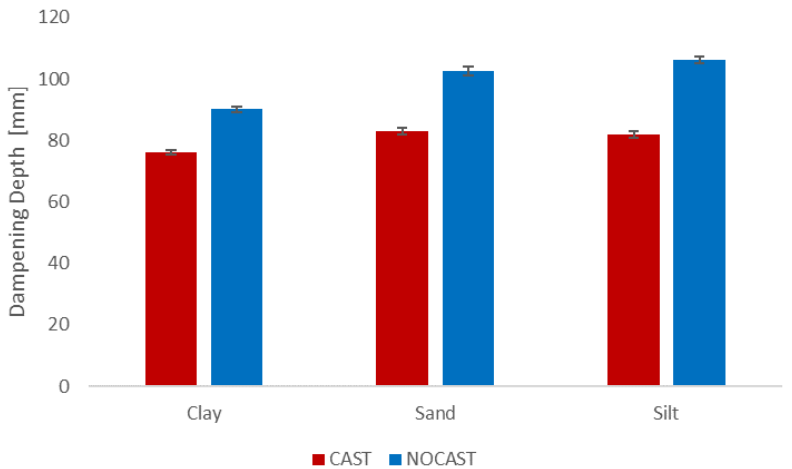
Figure 5. Comparison of dampening depth for CAST and NOCAST soils. Error bars represent 1 standard error.